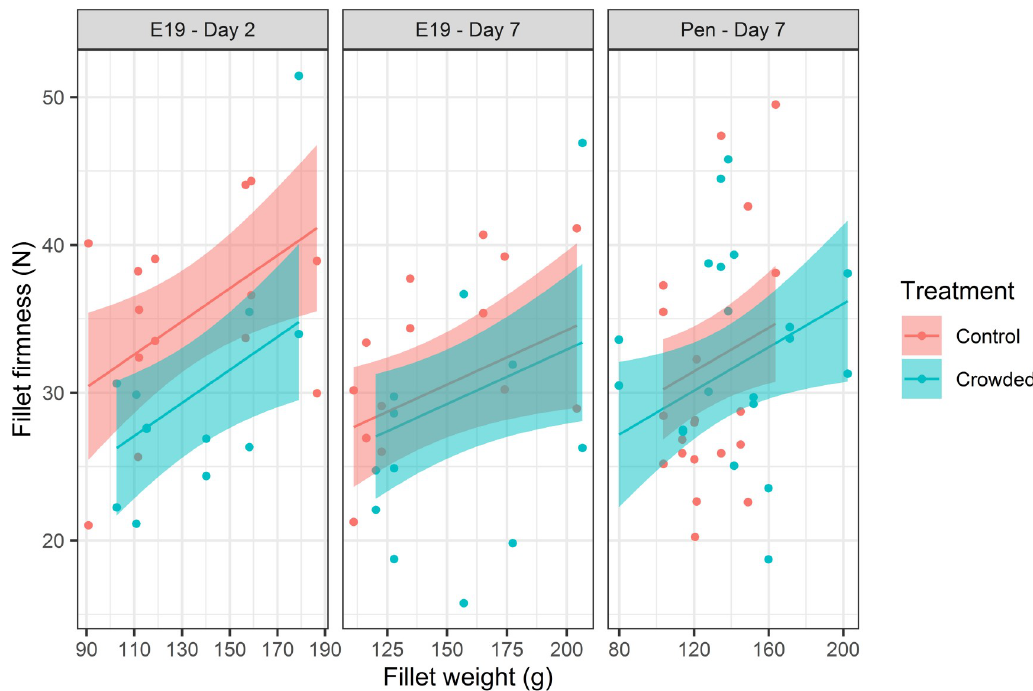
Fig 4. Post-mortem fillet firmness response to crowding in Atlantic mackerel. Fillet firmness were determined at two (“Day 2”) or seven (“Day 7”) days after death and from either Experiment E19 (“E19”) or the net pen experiment (“Pen”). The lines indicate the fitted relationship between fillet weight and firmness, with the 95% confidence intervals shown as shaded areas. The underlying dataset is shown as filled circles. Data points and lines are coloured according to treatment.